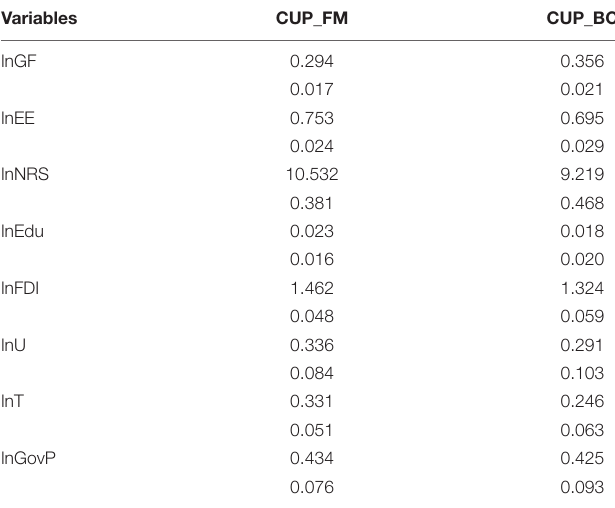
TABLE 6 | Results of the long-run coefficients (dependent variable: energy